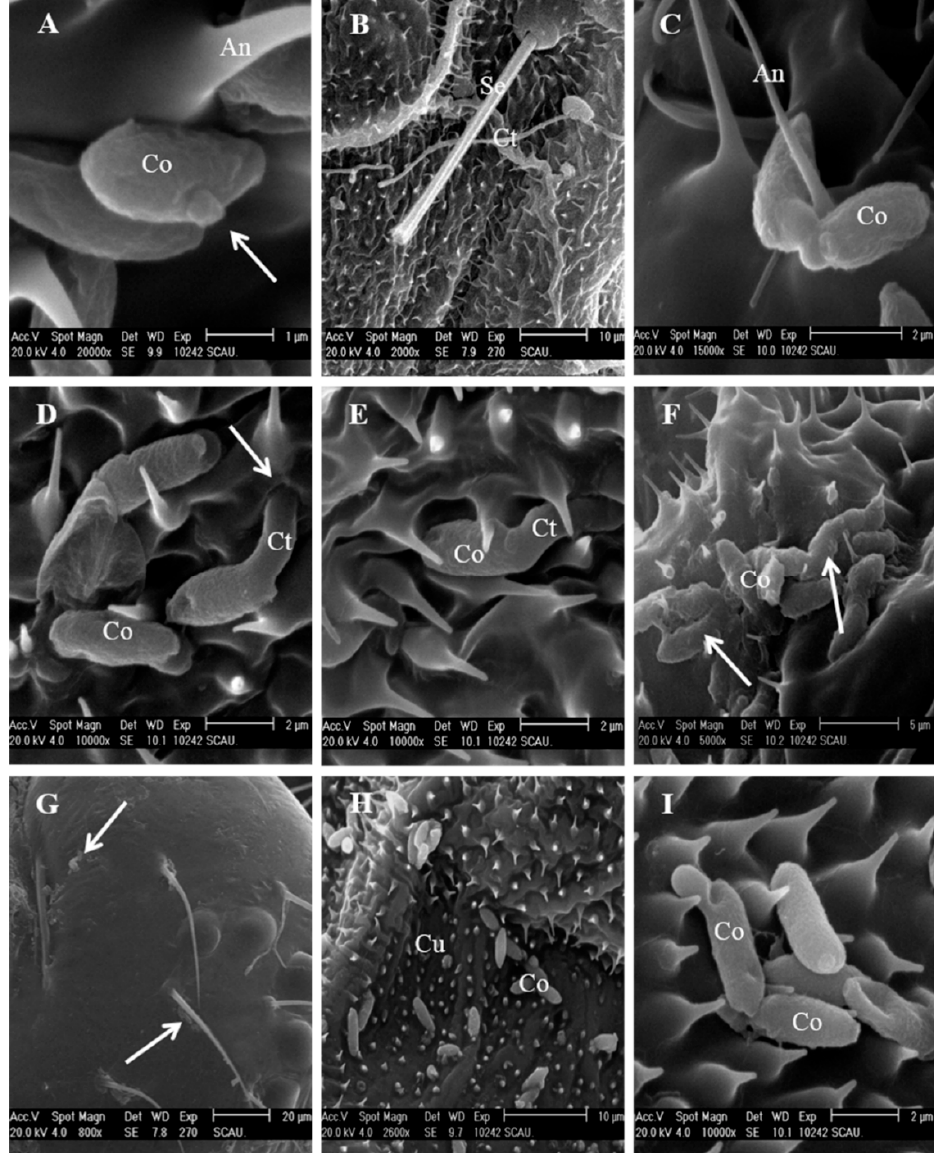
Figure 3. Conidial attachment and germination of Cordyceps fumosorosea on the cuticle of Plutella xylostella larvae observed under scanning electron microscope. A-F: IFCF01 strain; ( A ) A conidium (Co) attached to the abdominal pleuron surface and germinated to form a germ tube (arrow) at 4 h post-inoculation; An = antennae; ( B ) A pair of germ tubes formed from conidia at 16 h post-inoculation. Gt = germ tube, Se = seta; ( C ) Appressorium formation; ( D ) Conidia (Co) germinate, and the germ tube (Gt) penetrate (arrow) into the integument at the abdominal pleuron; ( E ) Germ-tube grew directionally along the base of the acanthae at the abdominal leg; ( F ) Appressoria covered with mucilage (arrows) at 8 h post-exposure. ( G – I ) : IFCF-D58 strain; ( G ) Very few attached conidia (arrows) showing germination to the head capsule at 8 h post- inoculation; ( H ) Conidia (Co) adhered to the thoracic pleuron at 8 h post-inoculation. Cu = cuticle; ( I ) Conidia (Co) attach to the thoracic leg and germinate to form a germ tube at 16 h